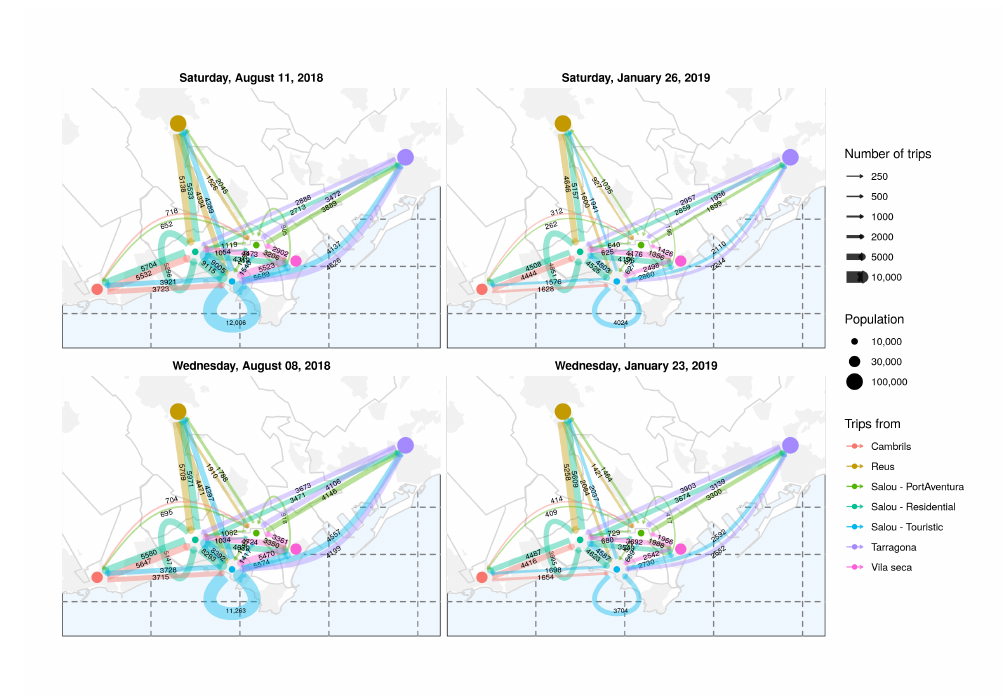
Figure 4. Flow maps of the intra-urban and inter-urban mobility in Salou of the residents in the province of